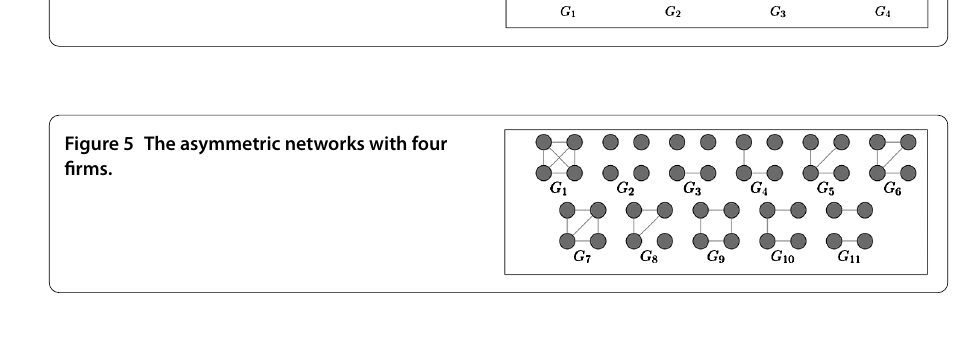
Figure 6 The total welfare of asymmetric networks given in Figures 4 and 5. The parameters used to plot the figures are a = 2, c = 1 and γ = 1 if n = 3 and γ = 2 if n =